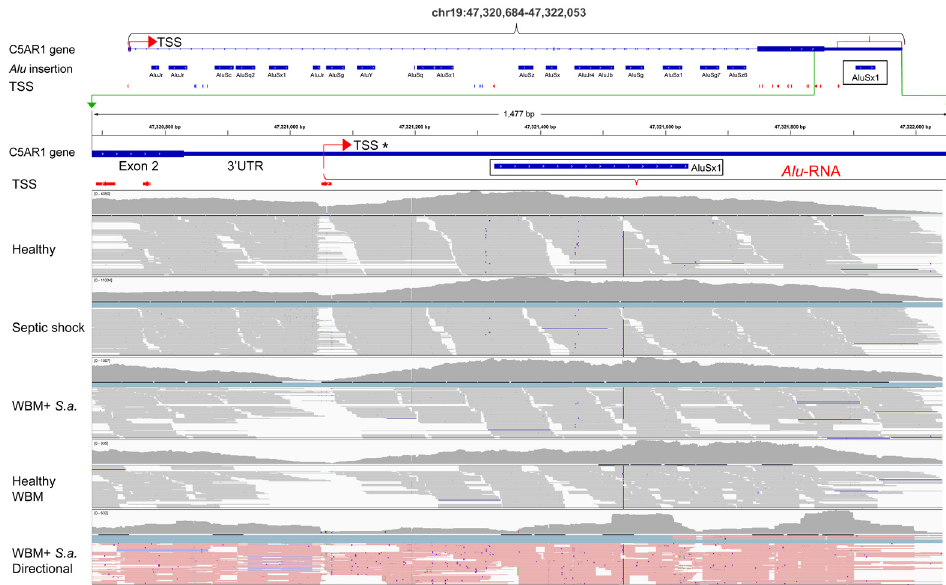
Figure 3. IGV presentation of the structure of the C5aR1 gene with corresponding RNA-seq align- ments. The top part shows the genomic structure of C5aR1 , including CAGE-confirmed TSSs and Alu elements. A zoom-in on the 3 ′ UTR beneath the green bracket includes alignments of RNA-seq data from the following samples: healthy, SRR12291428; septic shock, SRR12291512 (both from the Herwanto et al. study); WBM + S.a. , ex vivo whole blood model incubated with S.aureus for 120 min; Healthy WBM, ex vivo whole blood model incubated with phosphate-buffered saline (PBS) for 120 min; WBM + S.a. directional, ex vivo whole blood model incubated with S. aureus for 120 min, sequenced on Ion Torrent to generate directional reads (pink equals sense orientation). The TSS in the 3 ′ UTR is marked as TSS*.